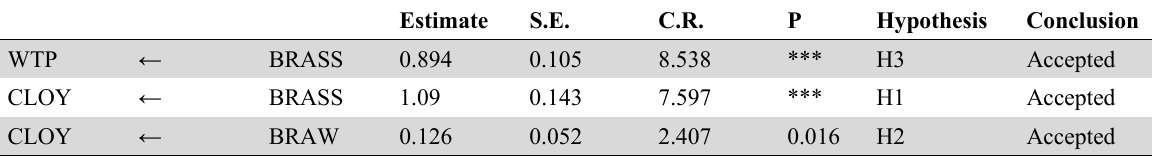
Unstandardized regression weights